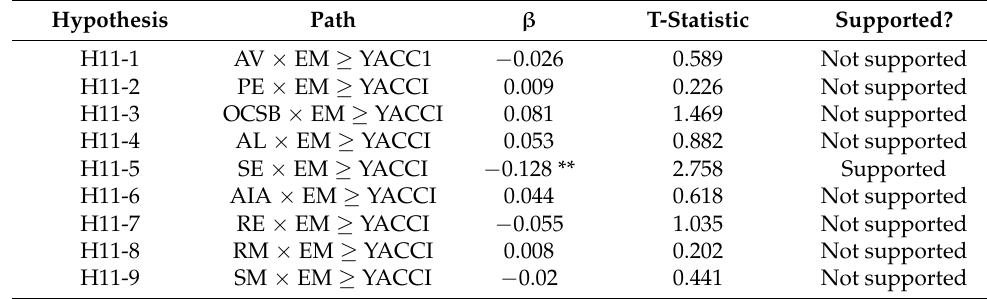
Table 6. Results of regulatory